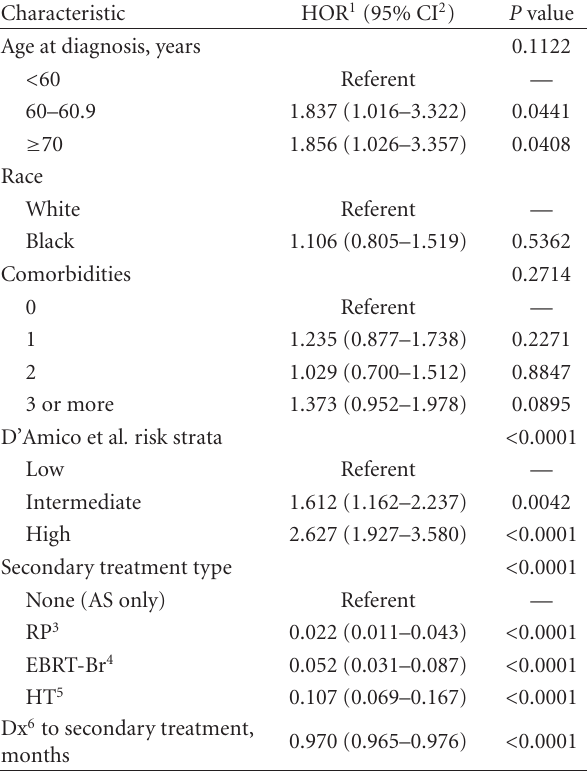
Table 3: Multivariable Cox proportional hazards regression pre- dicting overall survival in a cohort of subjects with prostate cancer (CaP) followed on active surveillance (AS) for primary treatment ( N = 886).